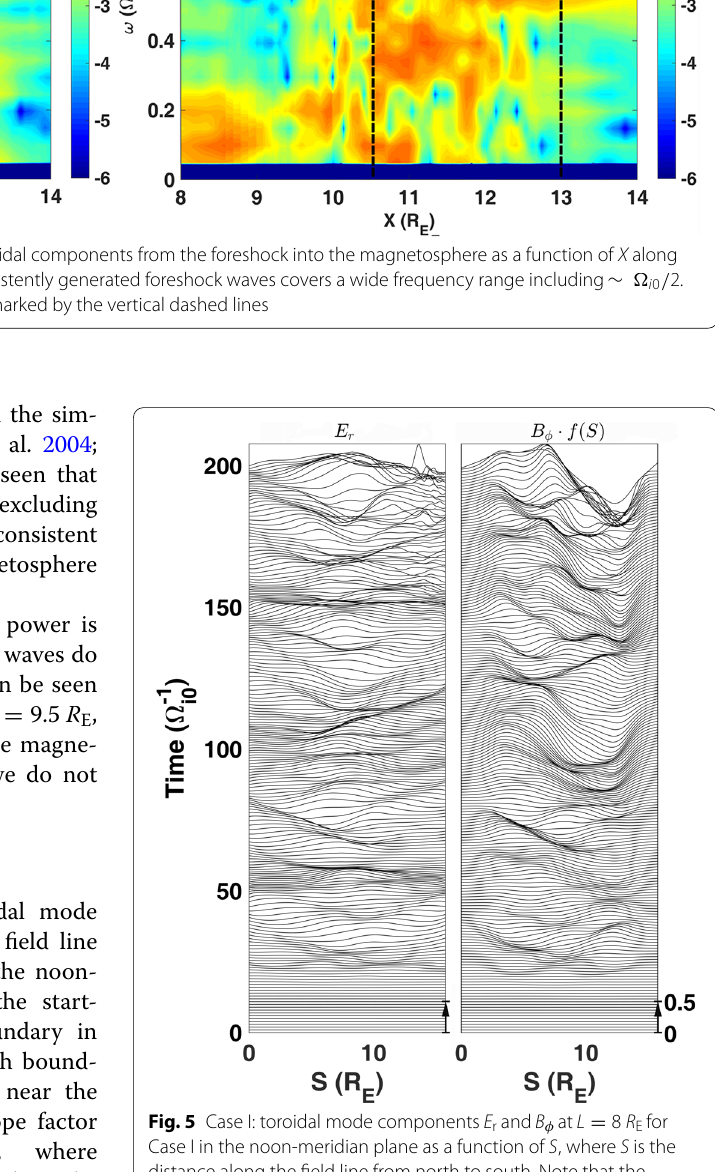
Fig. 5 Case I: toroidal mode components E r and B φ at L Case I in the noon-meridian plane as a function of S , where S is the distance along the field line from north to south. Note that the magnitudes of E r and B φ are marked on the bottom